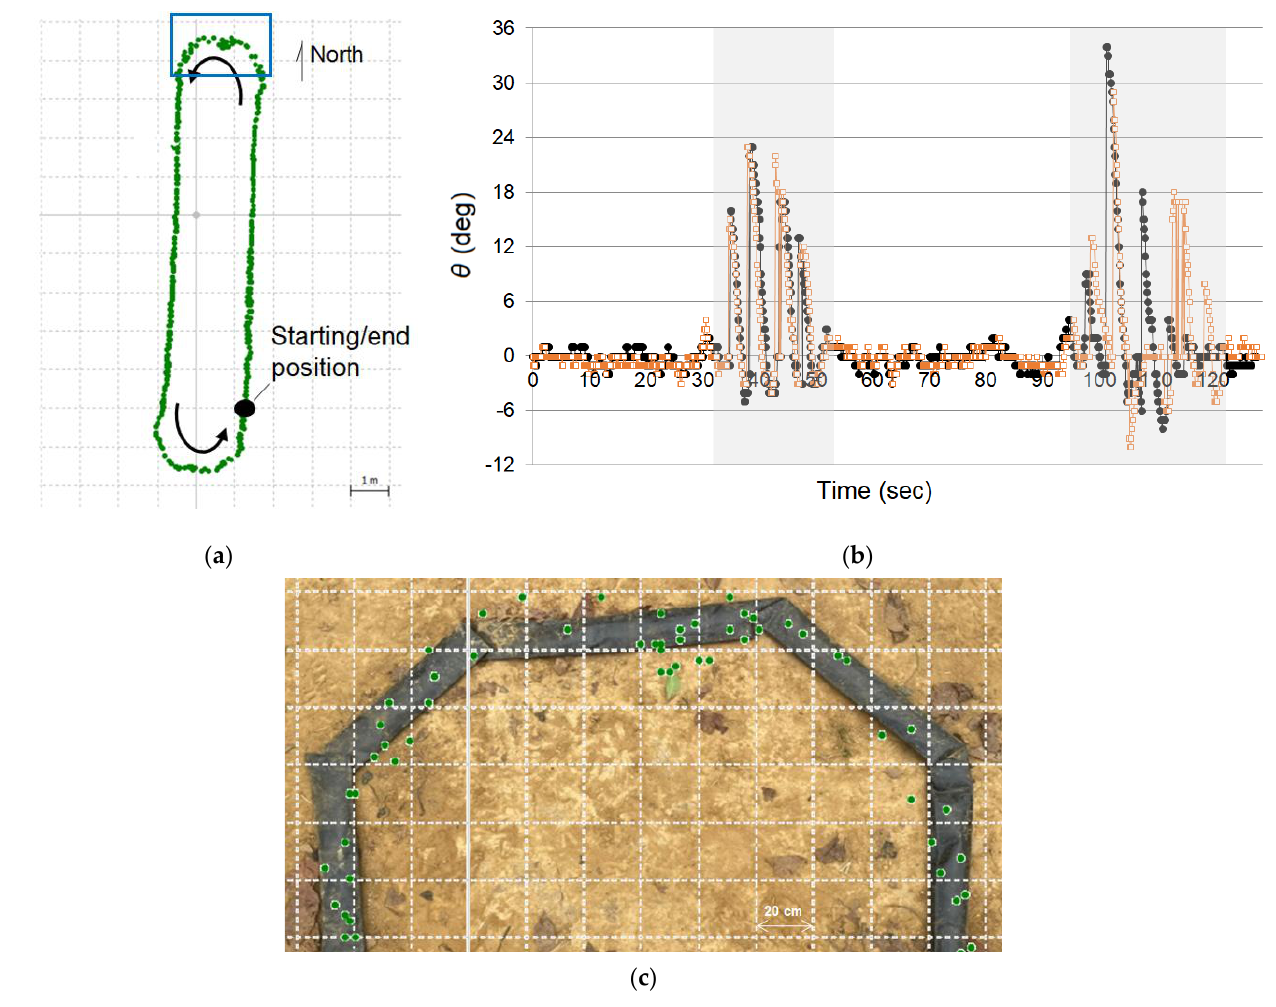
Figure 12. The movement trajectory and deviation angle of the robot (test time interval: 06:00 – 08:00 A.M.): ( a ) Movement trajectory of the robot, initial location: 22.64657 °N, 120.6060 °E (the area of grid: 1 (length) × 1 (width) m); ( b ) The variation in heading angle when the robot travels (black-dot color: the first loop; brown hollow-dot color: the second loop); ( c ) The position point (green-dot color) distribution of the moving trajectories of the two loop (the area of grid: 20 (L) × 20 (W)